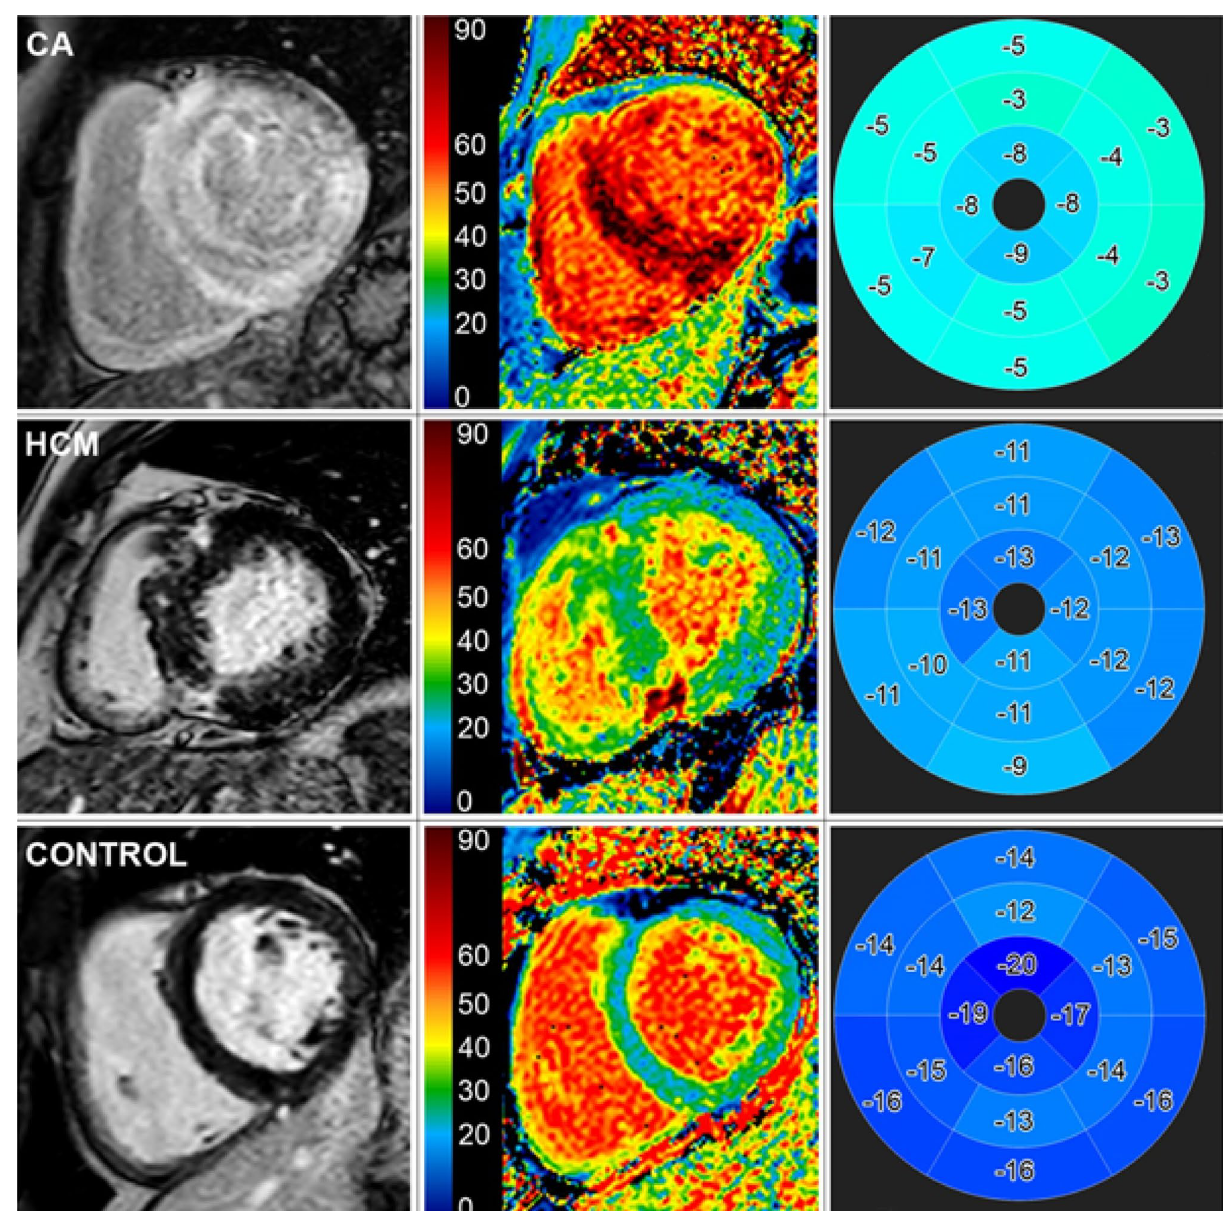
Figure 1. Late gadolinium enhancement (1st column), extracellular volume fraction maps (2nd column) and polar maps using a 16-segment model of peak longitudinal strain with values in percentage (3rd column) in short-axis views of a patient with cardiac amyloidosis (CA) (1st row), hypertrophic cardiomyopathy (HCM) (2nd row) and from the control group (3rd